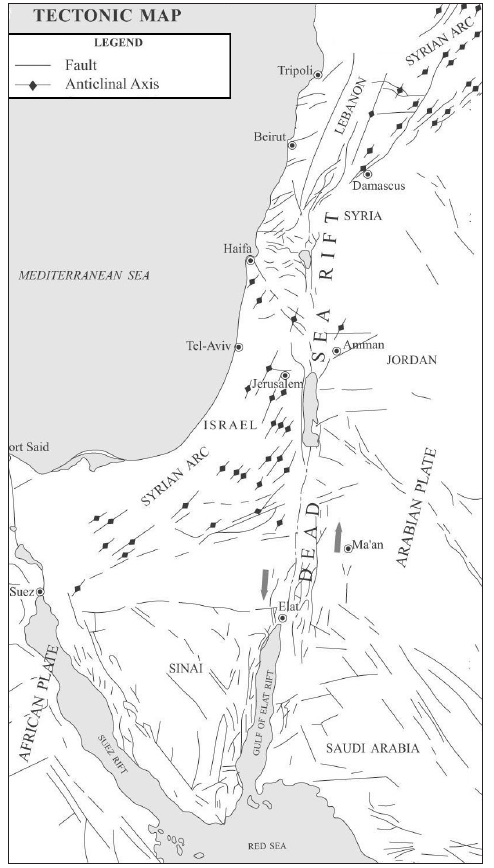
Fig. 1. Tectonic sketch map (after Picard, 1943; Bartov,